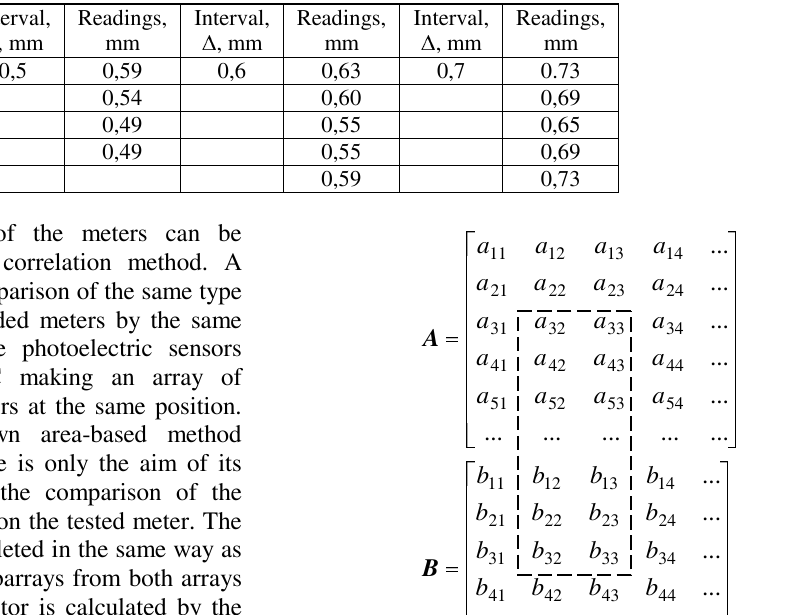
Table 2. Example of readings from the meter